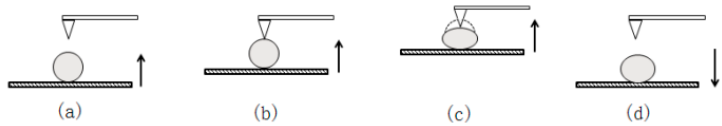
Figure 2. The test process of phase-change microcapsules’ (microPCMs) force curve: ( a ) the sample starts to rise, ( b ) the sample begins to contact with the probe, ( c ) maximum deformation of cantilever, and ( d ) the sample drop.